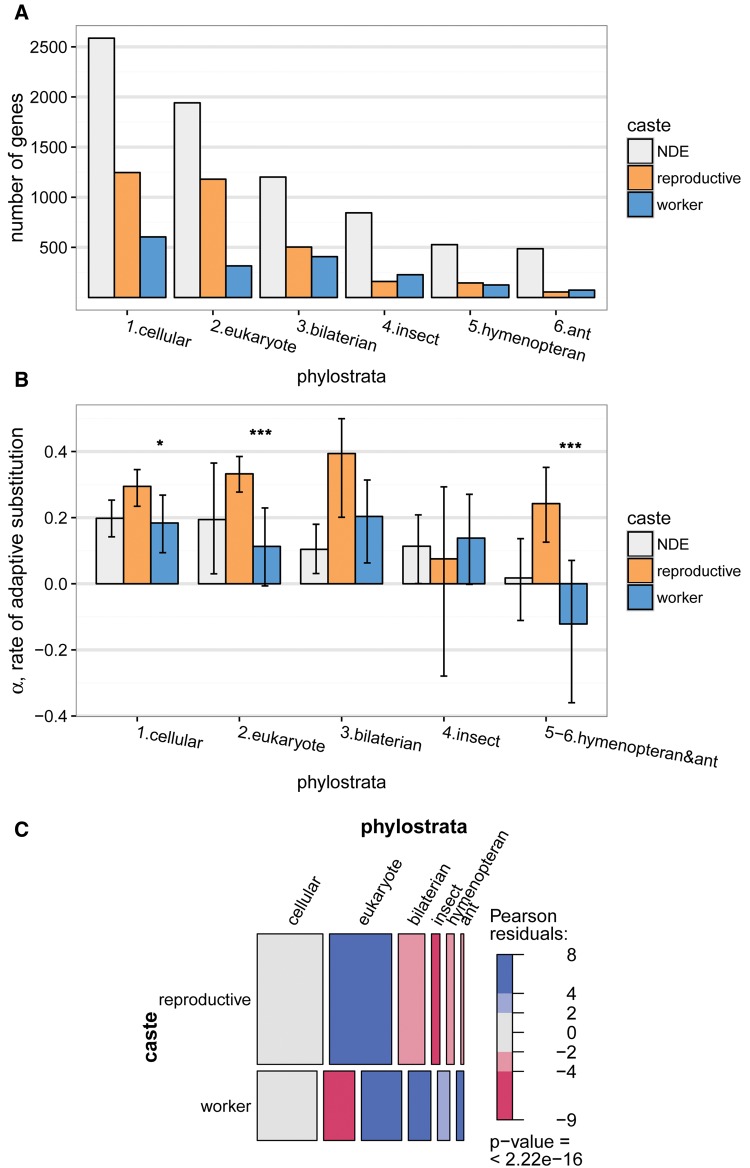
The contribution of ancient and young genes to caste evolution. (A) Most caste-associated genes, as well as NDE genes in the M. pharaonis genome, are from ancient phylostrata (supplementary fig. S6, Supplementary Material online). (B) Genes in the youngest phylostrata tend to show relaxed adaptive evolution (i.e., 95% CI of α overlapping zero), except for reproductive-associated genes in the hymenopteran and ant phylostratum. Genes in the two oldest phylostrata mainly drive the pattern of higher rates of adaptive evolution for reproductive-associated genes relative to worker-associated genes (fig. 1C); *P < 0.05, ***P < 0.001. The last two phylostrata (hymenopteran and ant) were combined because there are not enough ant-specific genes for accurate α estimates. (C) Mosaic plot showing that relative to reproductive-associated genes, worker-associated genes are enriched for the four youngest phylostrata, while reproductive-upregulated genes are enriched for the eukaryote phylostratum. The area of each cell is proportional to the number of genes in each caste and phylostrata category. Blue shading indicates overrepresentation (light blue P < 0.05, dark blue P < 0.001), and red-shading indicates underrepresentation (light red P < 0.05, dark red, P < 0.001), based on cell standardized Pearson residuals.